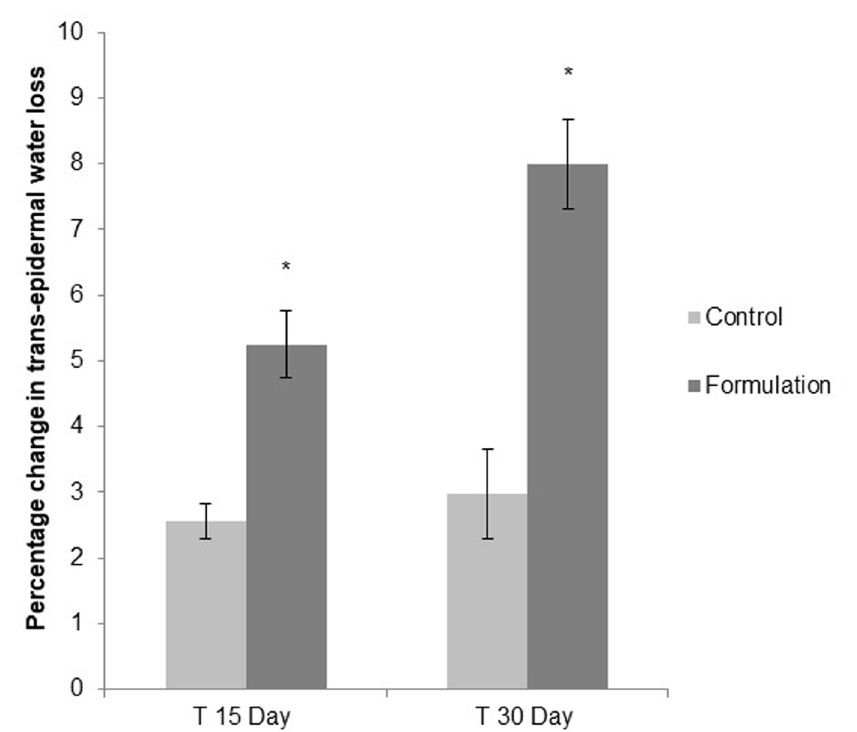
FIGURE 4 - Percentage decrease in trans-epidermal water loss for the control (hydrogel without the Gac extract) and the formulation containing the Gac extract after the 15- and 30-day application period compared to values before treatment (mean ± SD). * Significantly different from day zero of each treatment ( p ≤